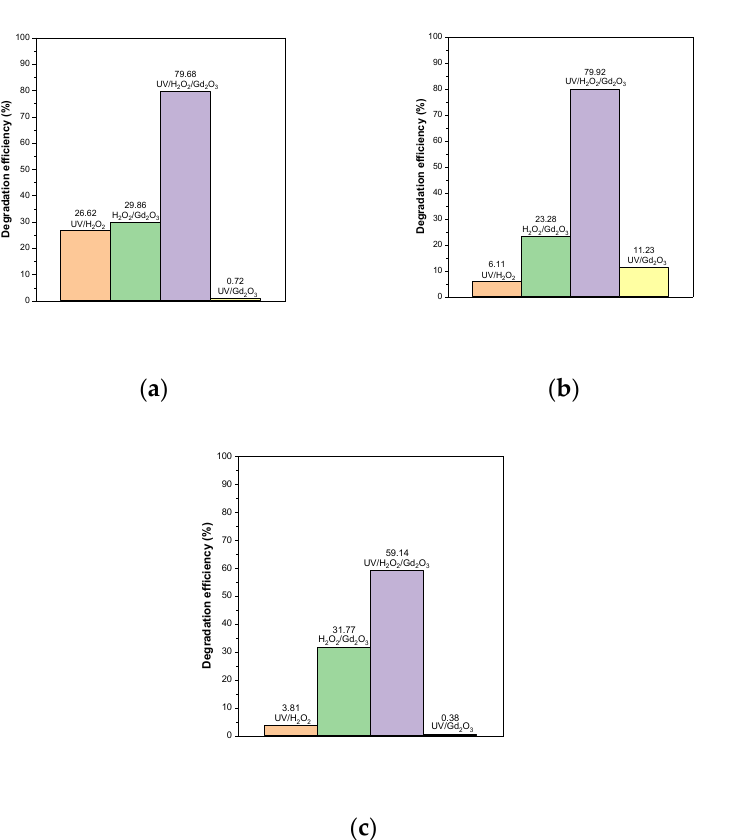
Figure 7. Histograms of photocatalytic degradation efficiency of ( a ) MO, ( b ) AO7, and ( c ) AY23 under different conditions after 100 min. (Experimental conditions: initial dye concentration: 0.042 mM; photocatalyst concentration: 1.0 g/L; H 2 O 2 concentration: 4.8M; wavelength of UV irradiation: 254 nm).